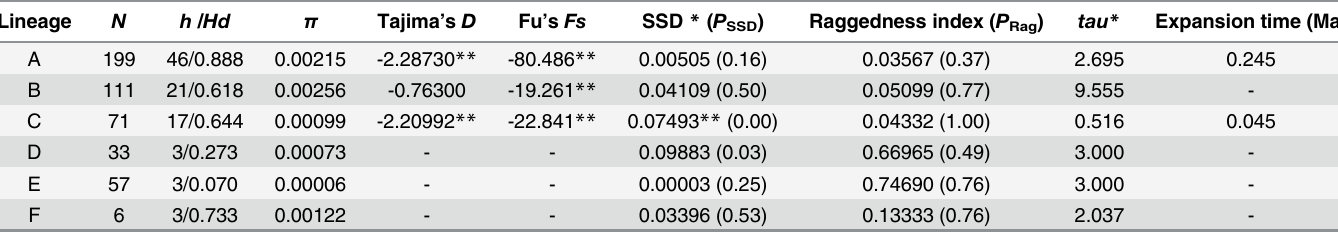
Table 2. Summary statistics observed in major lineages of O . schmackeri species